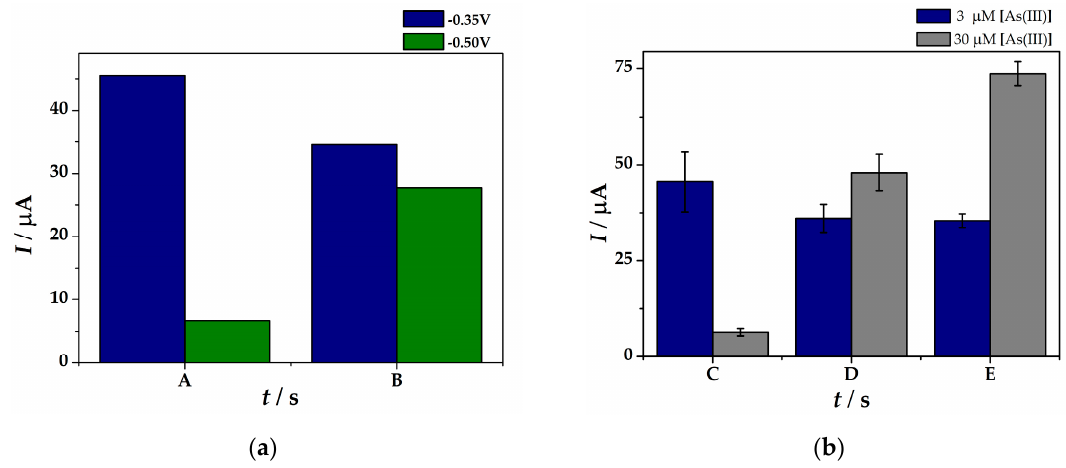
Figure 3. Peak current intensities obtained by means of SWASV measurements at ( IV )Au-PtNPs / SPCE from solutions containing 3 µ M As(III) (blue) and 30 µ M As(III) (grey) in 6.0 M LiCl in H 2 SO 4 0.1 M by potential-assisted cathodic pre-concentration of ( a ) t dep = 120 s (A) and 240 s (B) at E dep = − 0.35 V (blue) and E dep = − 0.50 V (green); and ( b ) t dep = 120 s (C), 180 s (D), 240 s (E) at E dep = − 0.50 V.